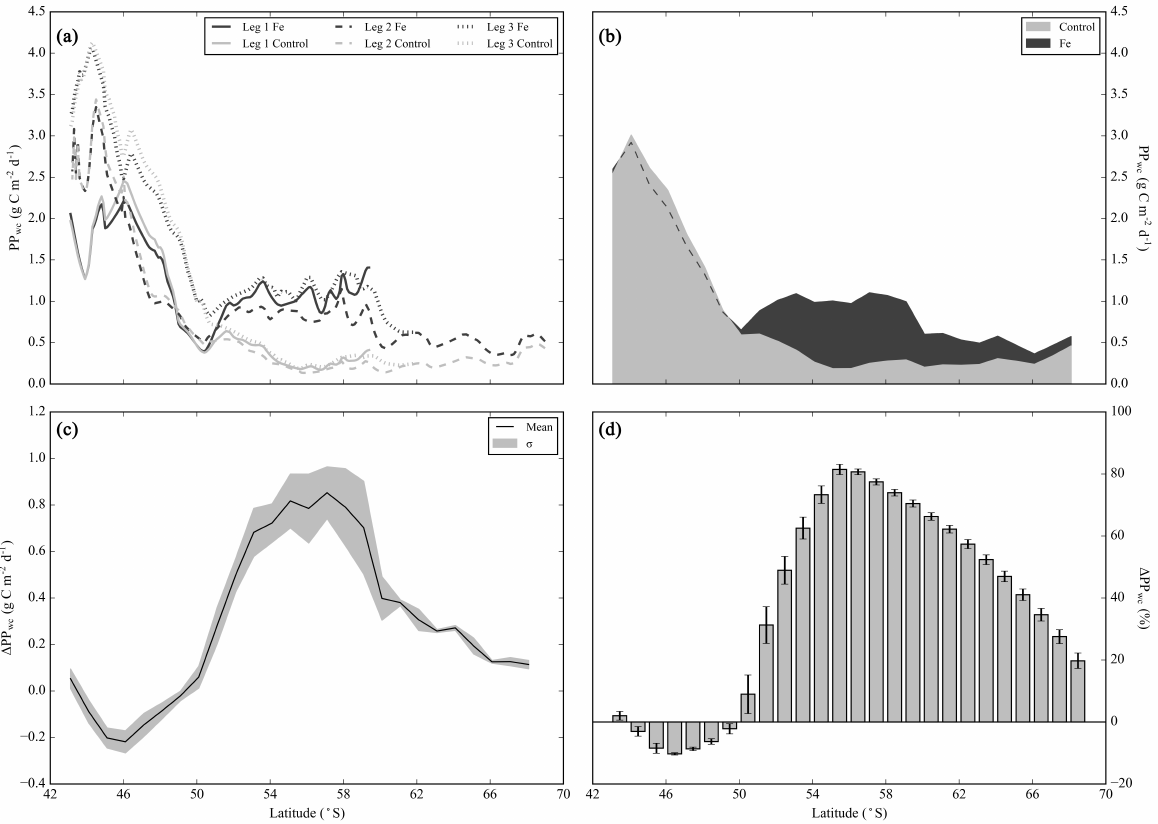
Figure 6. Depth-integrated primary production (PP wc ) (mgCm − 2 d − 1 ) for each transect (Leg 1–3) (a) interpolated along the transect line utilizing linearly interpolated values for α and P max as determined from the Fe and Control treatments. (b) Mean PP wc (mgCm − 2 d − 1 ) with ± standard deviation ( σ) . (c) The mean absolute differences in PP wc ( (cid:49) PP wc ) with ± standard deviation between the Fe and Control treatments. (d) (cid:49) PP wc represented as the mean percentage difference with ± standard